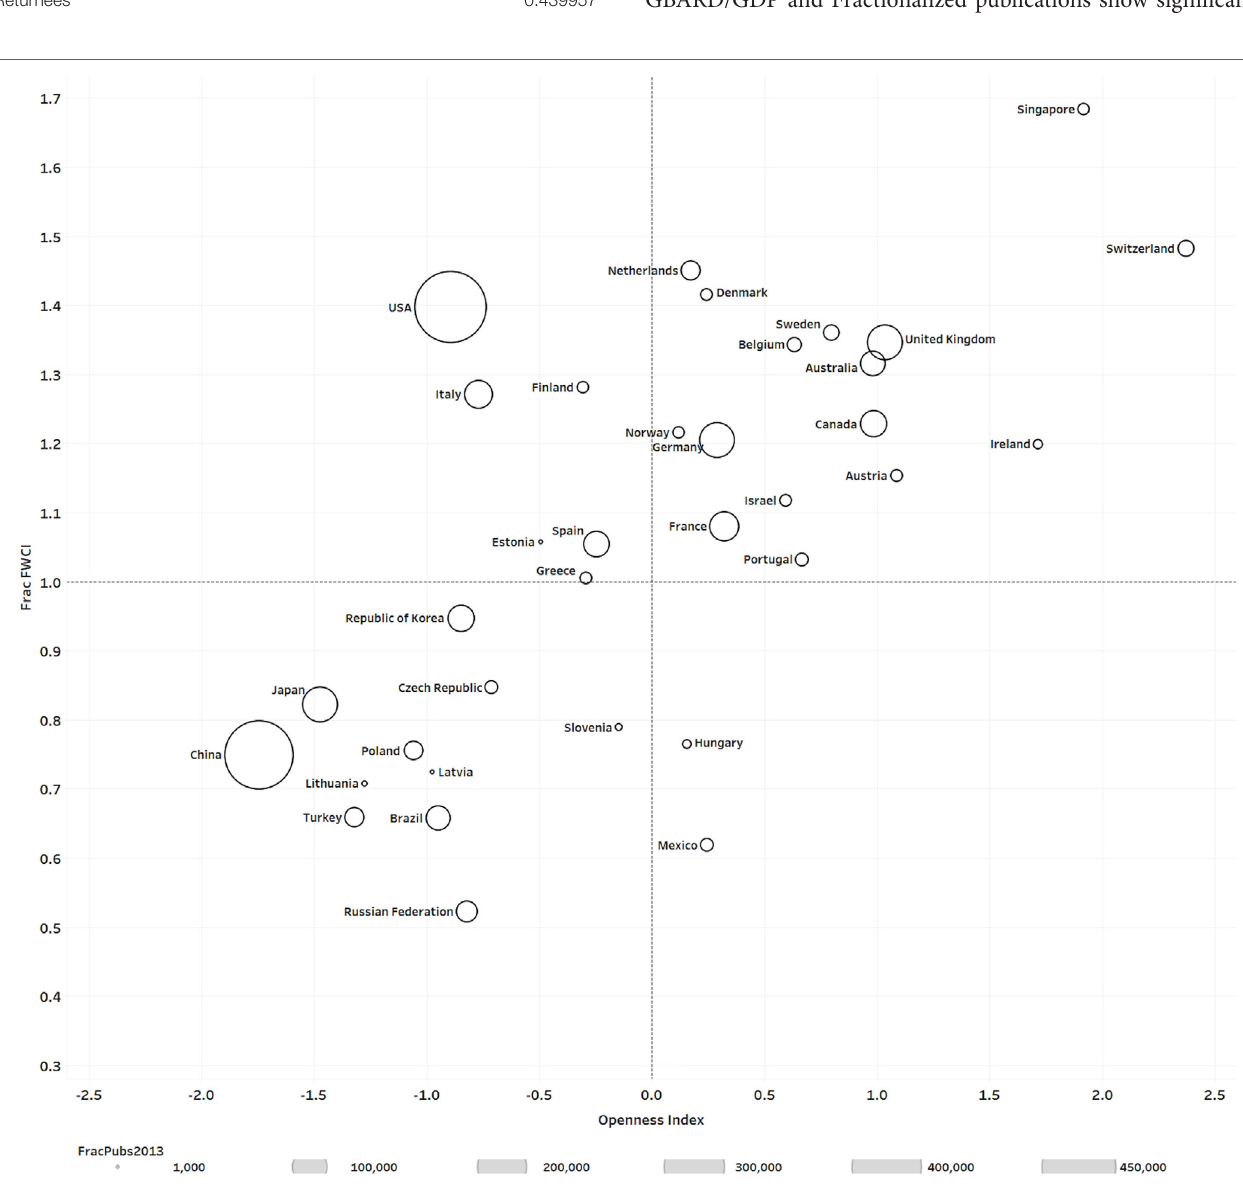
FigUre 1 | Scatterplot of fractional field-weighted citation impact (FWCI) and openness.